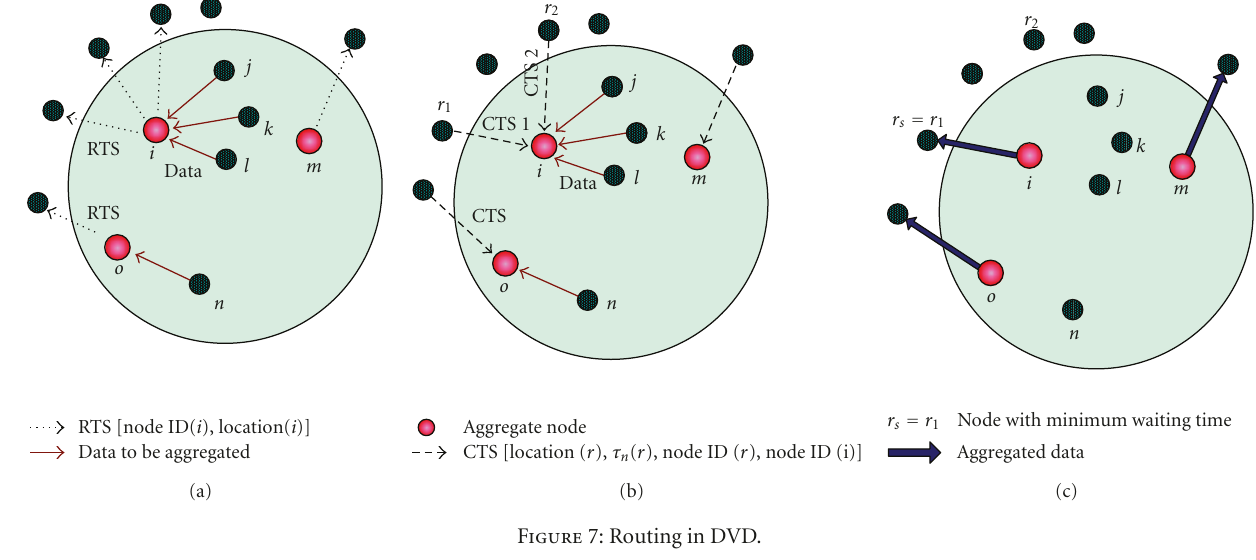
Figure 7: Routing in DVD.